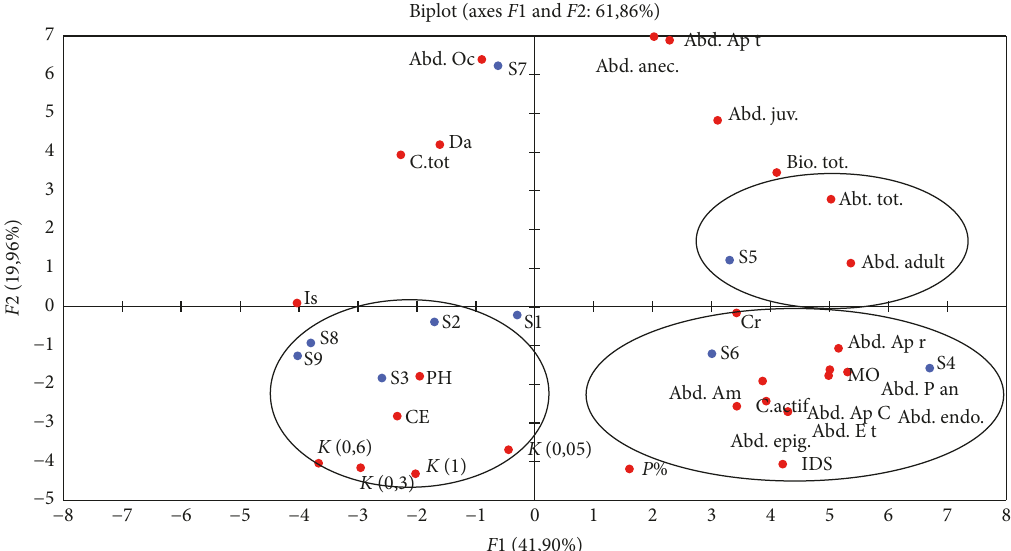
Figure 12: PCA graph of interaction between studied soil